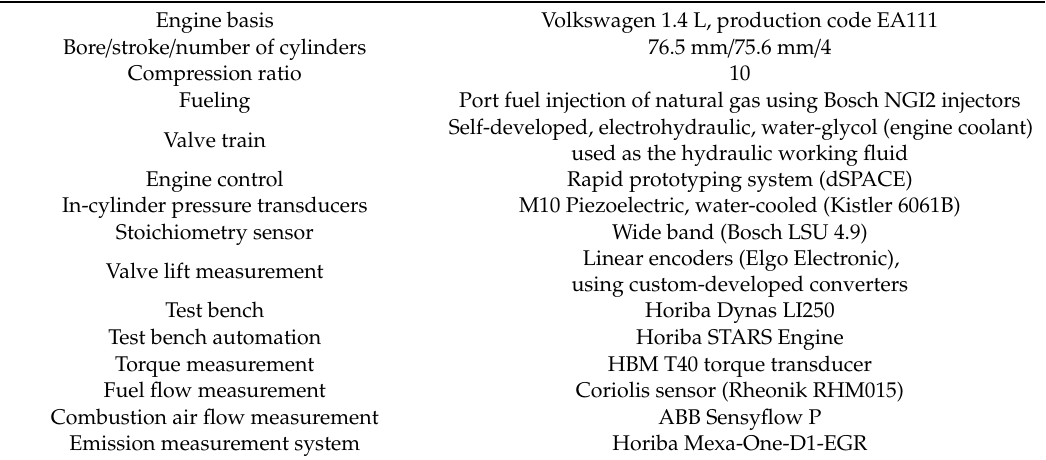
Table 1. Main characteristics of the experimental